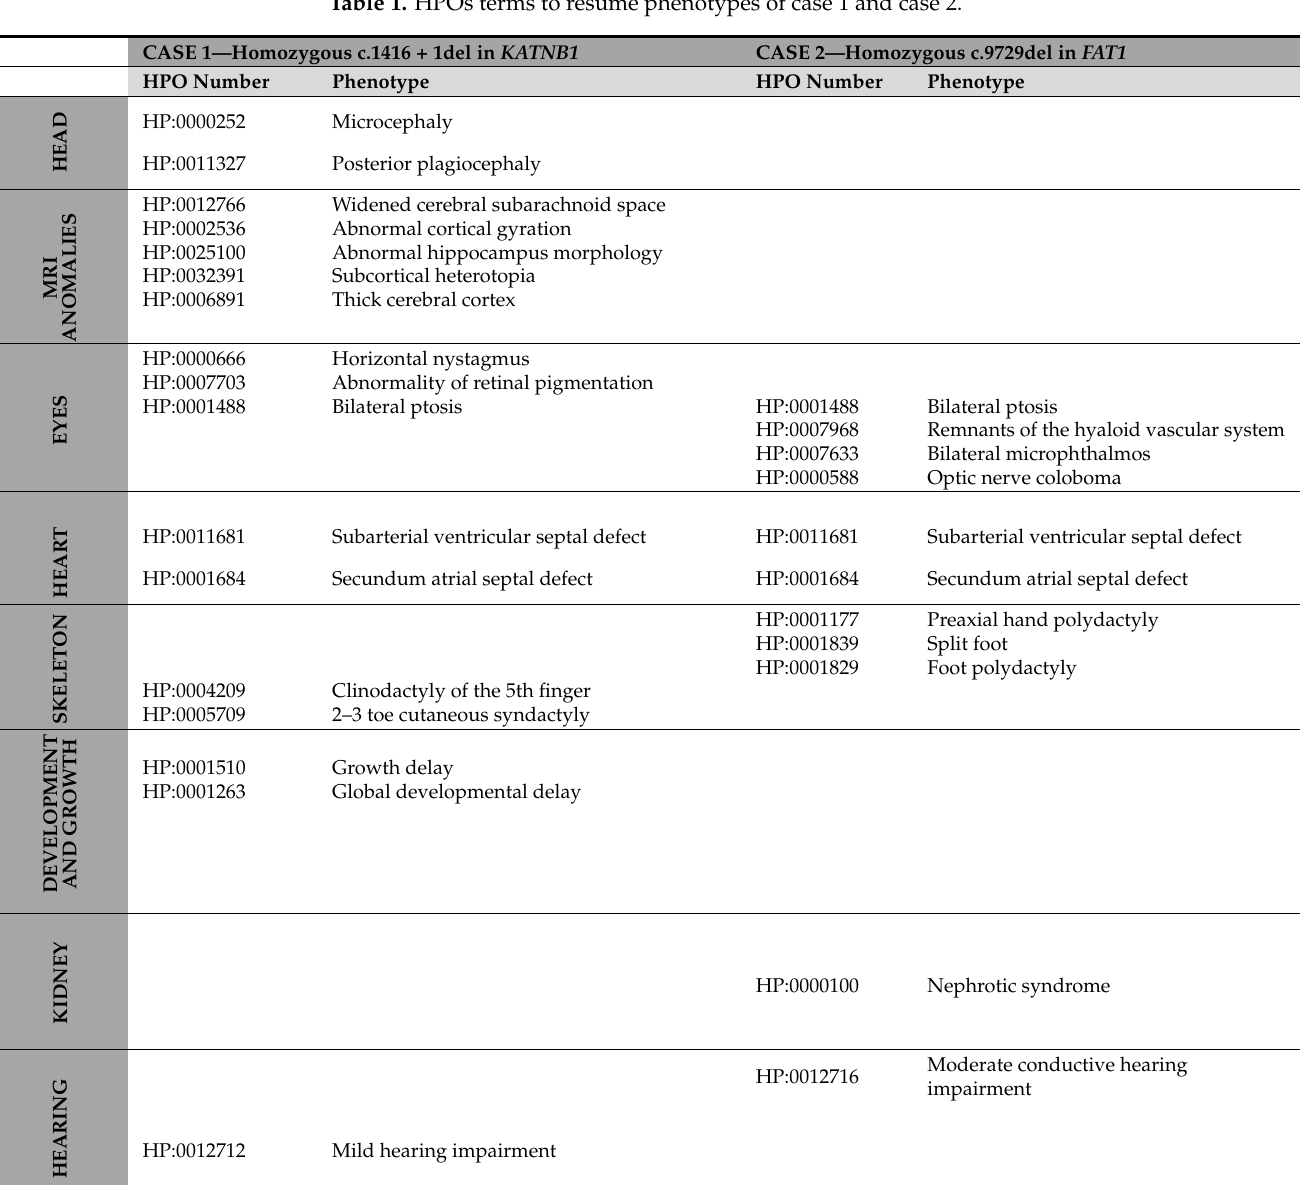
Table 1. HPOs terms to resume phenotypes of case 1 and case